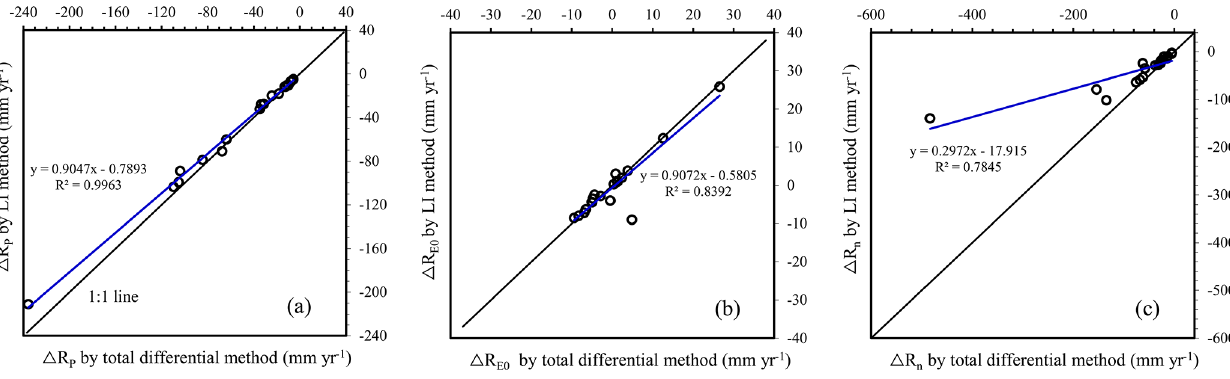
Figure 5. Comparisons of the estimated contribution to runoff from the changes in (a) precipitation ( (cid:49)R P ) , (b) potential evapotranspiration ) , and (c) catchment properties ( (cid:49)R n ) between the LI method and the total-differential ( (cid:49)R E 0